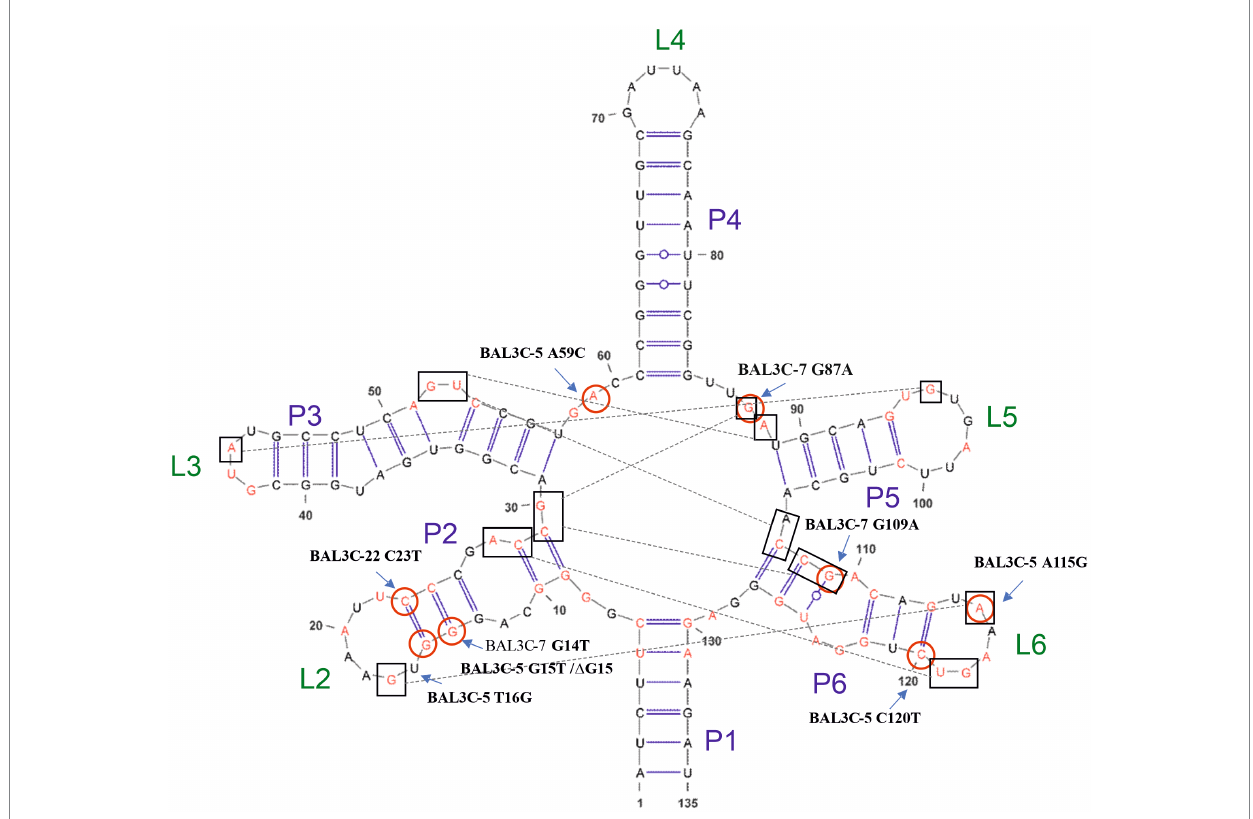
FIGURE 5 Model of the FMN riboswitch aptamer of Weissella cibaria based on the crystallographic studies performed by Serganov et al. (2009). Included in boxes are the nucleotides that could interact which each other for the conformation of the tertiary structure together with the FMN. In red, conserved nucleotides among distant species are depicted. Also, positions of detected mutations are